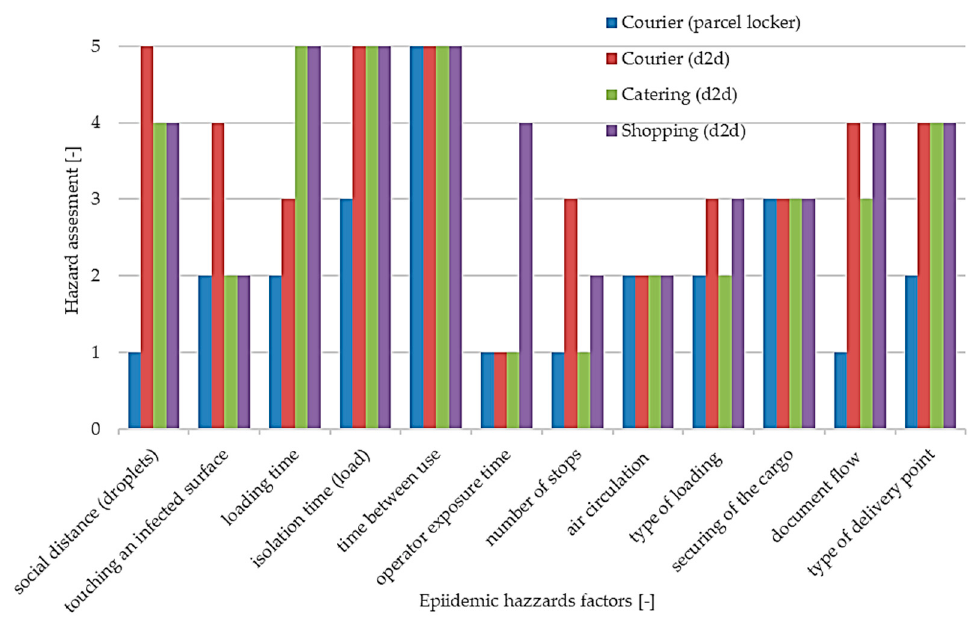
Figure 6. Assessment of all hazards and factors for delivery services.